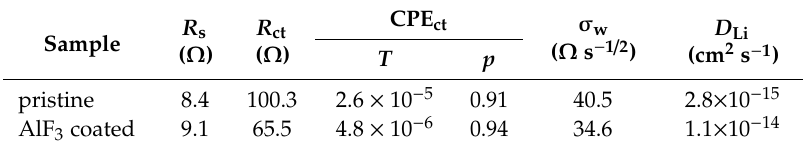
Table 4. Transport parameters of Li 1.2 Ni 0.2 Mn 0.6 O 2 electrodes deduced from EIS measurements.